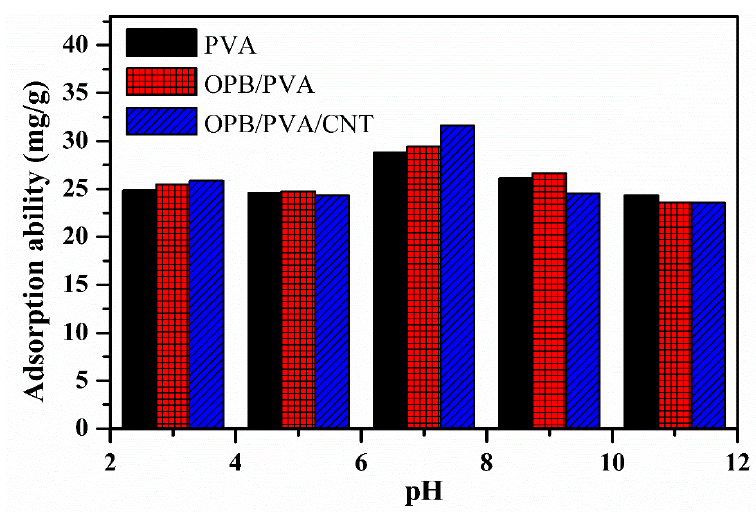
Figure 8. Effect of pH for the adsorption of Pb(II) onto the PVA, OPB/PVA and OPB/PVA/MWCNTs hydrogel adsorbents. Experimental conditions: adsorbent dose = 0.5 g, Pb(II) concentration = 65 mg/L and maximum adsorption time = 300 min (1, 3, 5, 10, 20, 30, 60, 120, 180, 240 and 300 min) at room temperature.